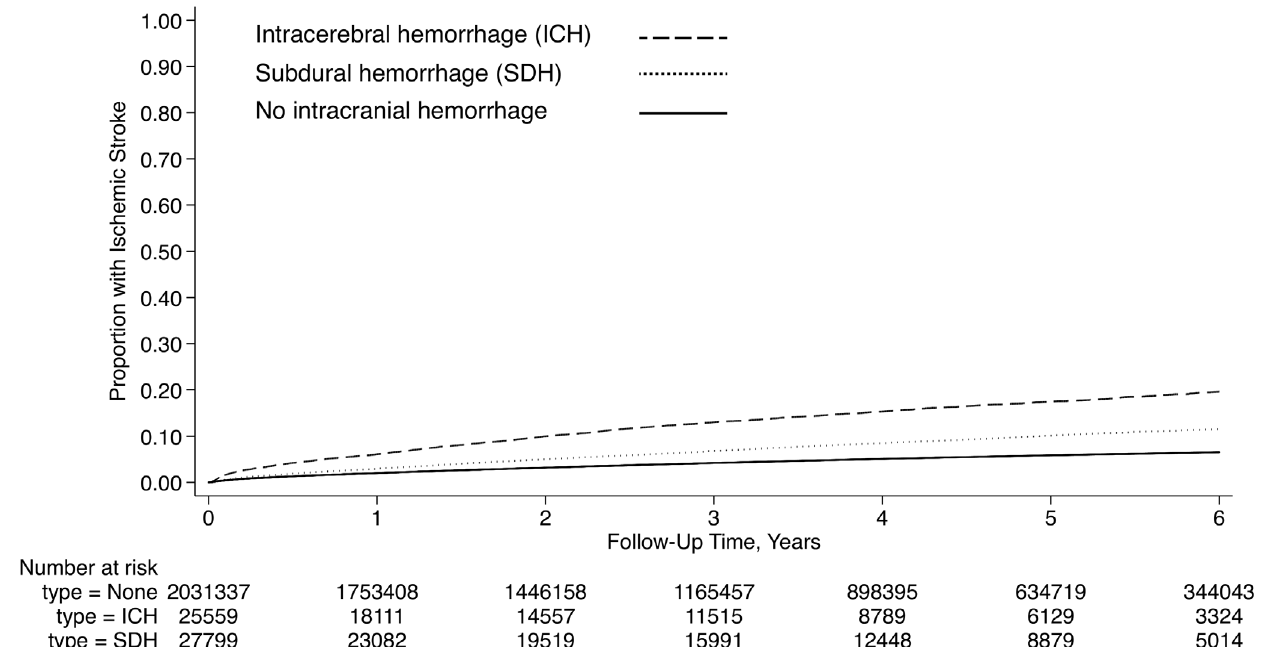
Fig 1. Cumulative ischemic stroke rates in atrial fibrillation patients, stratified by intracranial hemorrhage status. Differences between groups were significant ( P < 0.001 for test of trend).